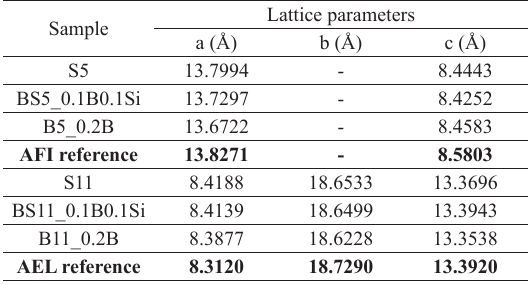
Table 3. Lattice parameters of AFI and AEL samples obtained by Rietveld refinement.